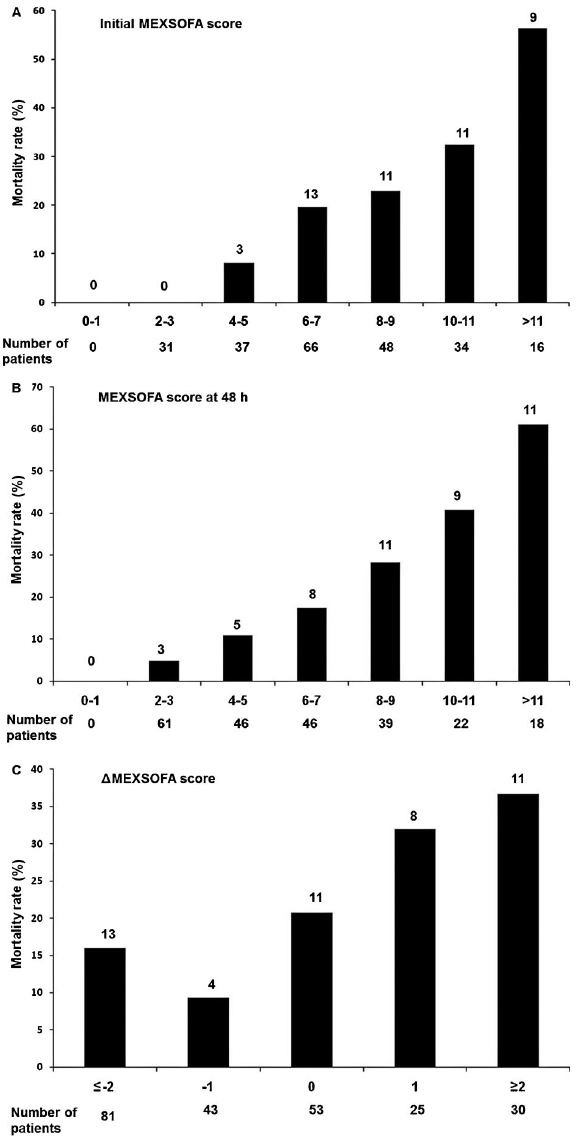
Figure 1. Mortality rate in relation to the changes in the Mexican sequential organ failure assessment (MEXSOFA) score during the first 48 h in the intensive care unit. Numbers above the bars indicate number of deaths. D MEXSOFA score = difference between the 48-h score and the initial